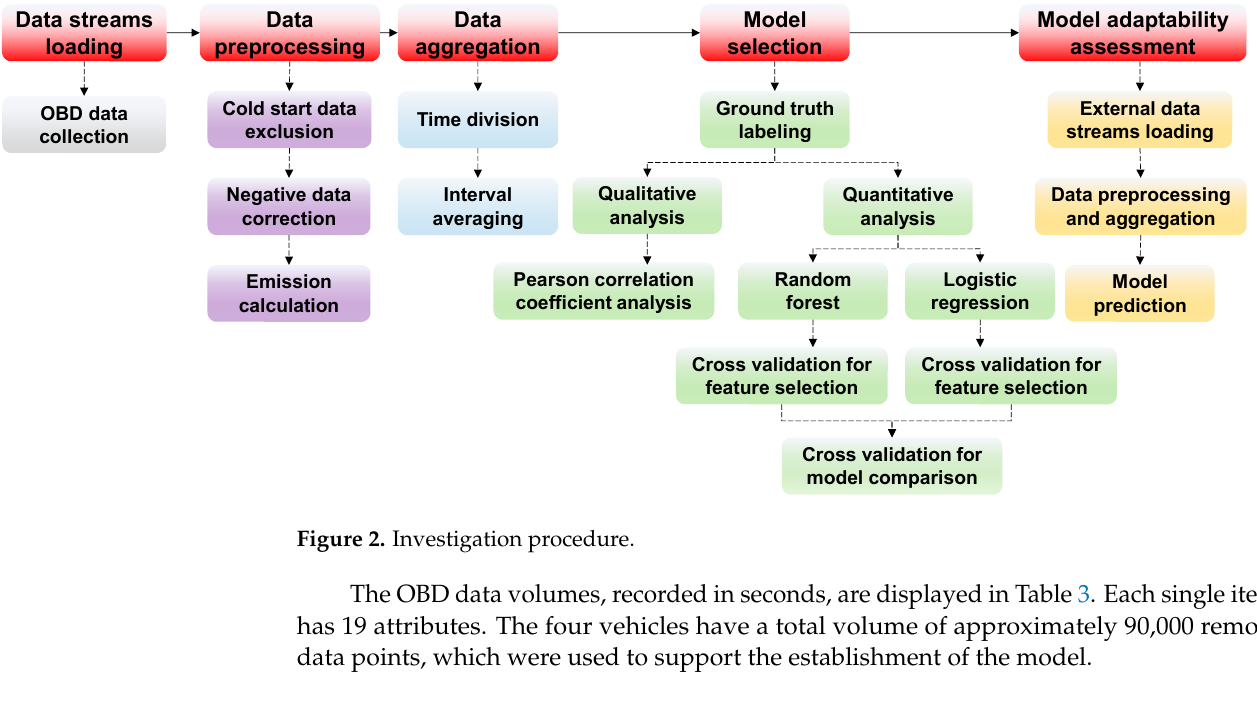
Figure 1. System topology diagram.